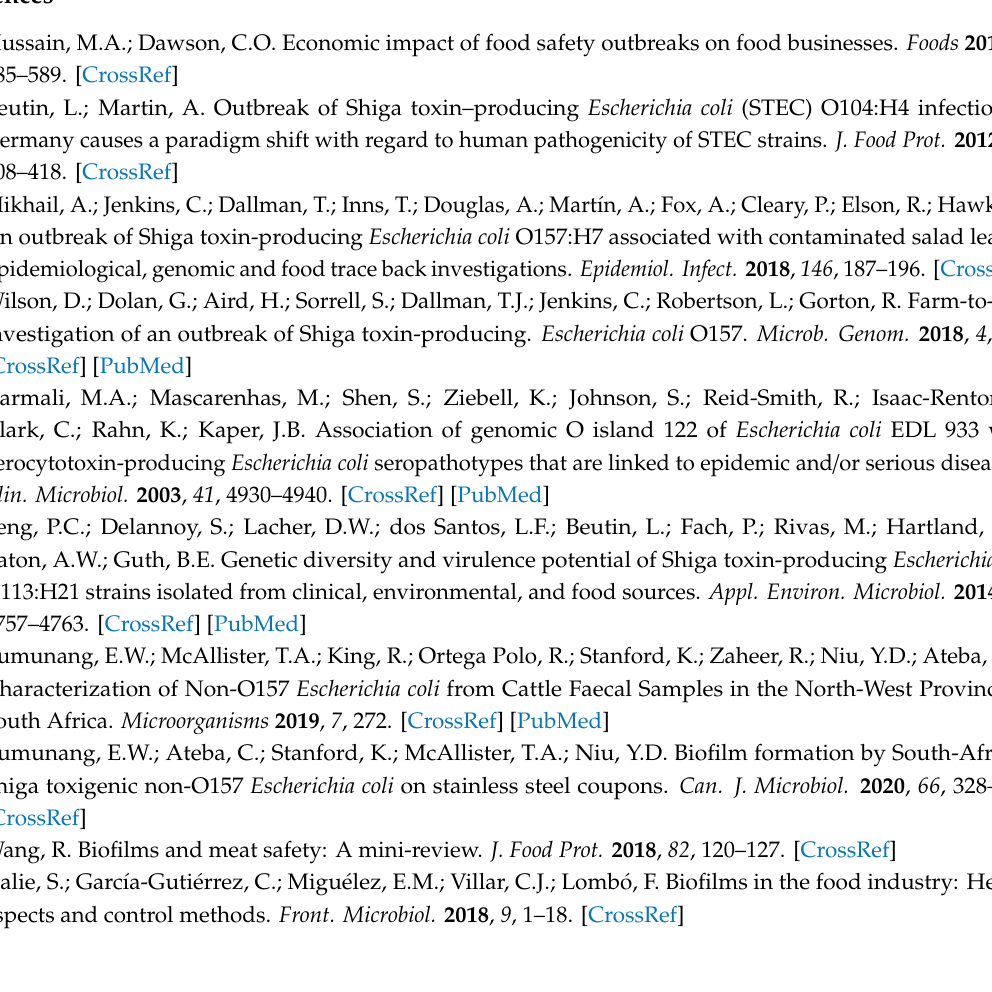
Figure S1: E ff ect of phlorotannin (PT; 50 µ g / mL) on phage SA21RB using soft agar overlay technique. Bacteria only (no phage and PT (A)); bacteria, phage and PT (dilution 1 (B)); bacteria, phage and PT (dilution 8 (C)); soft agar only (no bacteria, phage and PT (D)); bacteria and phage only (no PT dilution 1 (E)) and bacteria and phage only (no PT dilution 8